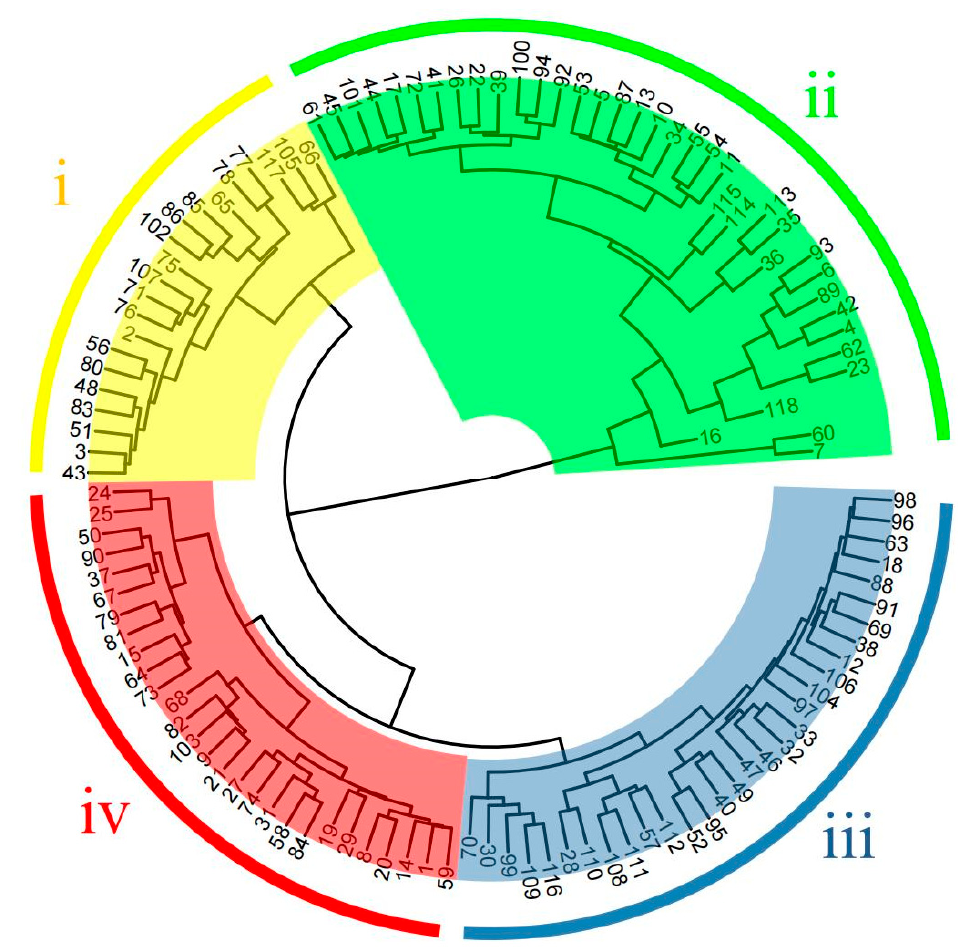
Figure 1. Cluster analysis of phenotypic traits in 118 materials. The labels in the figure represent the material number (corresponding to Table S4). Table 1. Descriptive statistical analysis of phenotypic traits used for characterization of the Castanea